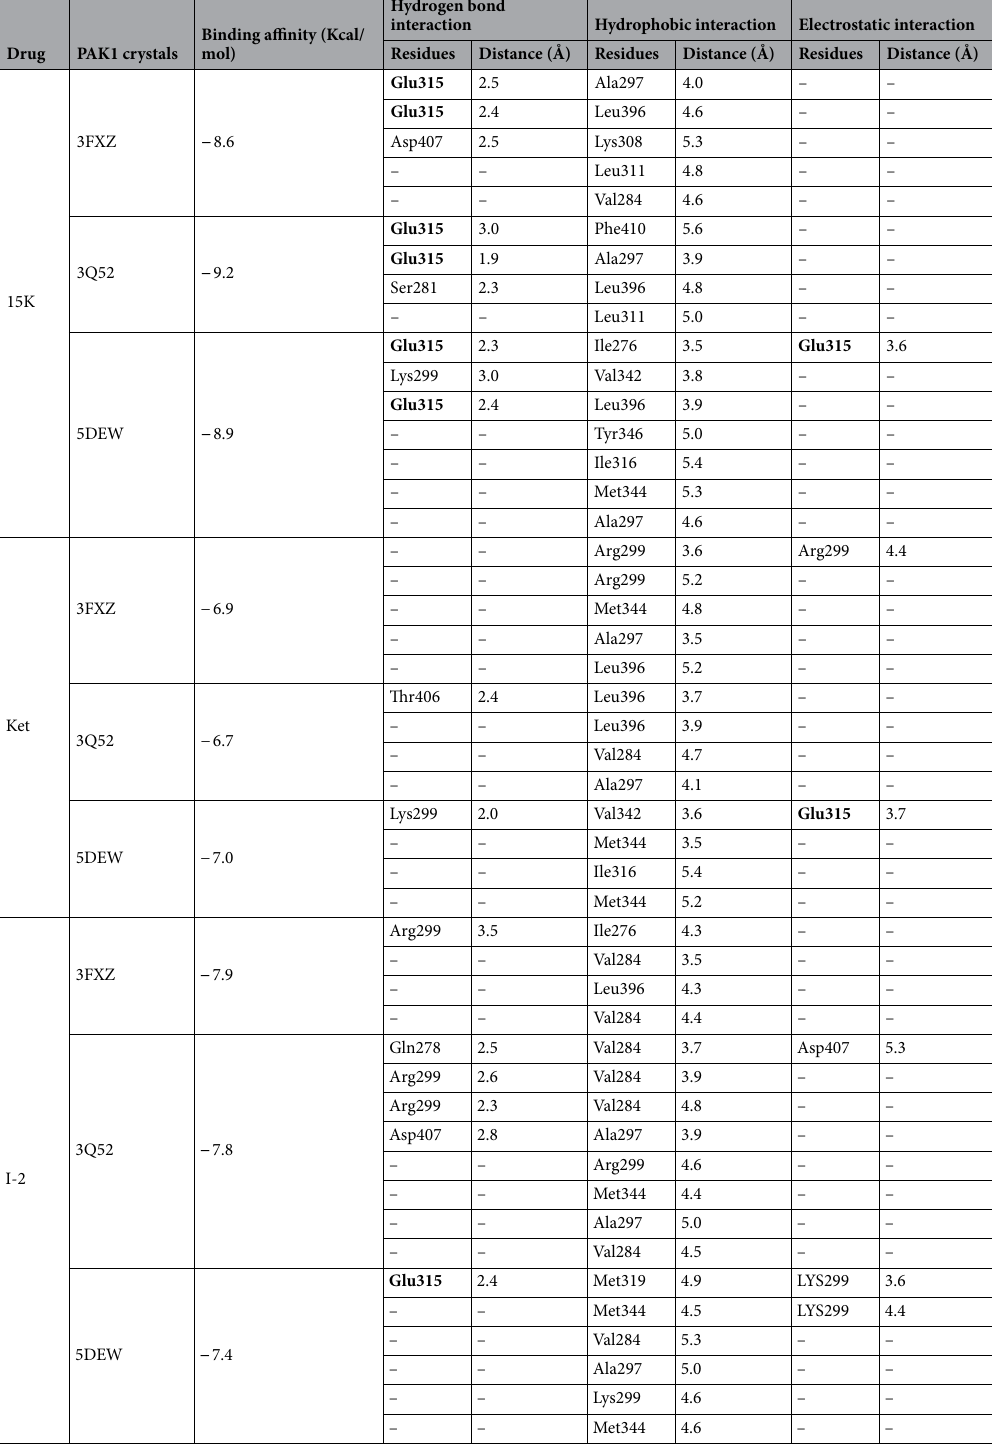
Table 4. Binding affinities and molecular interactions of 15K, ketorolac, and inhibitor 2 with three different crystal structures of PAK1. Ket ketorolac, I-2 Inhibitor